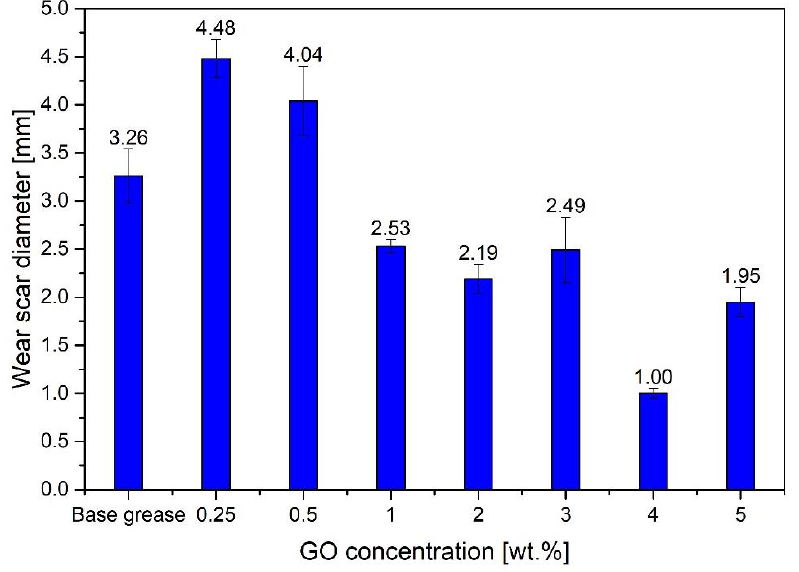
Figure 8. Influence of the concentration of GO additive on the tribological properties of a lubri- cant.